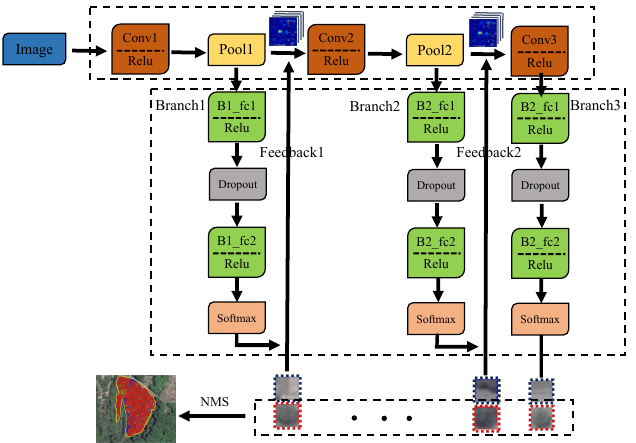
Figure 14. The progressive process of classification